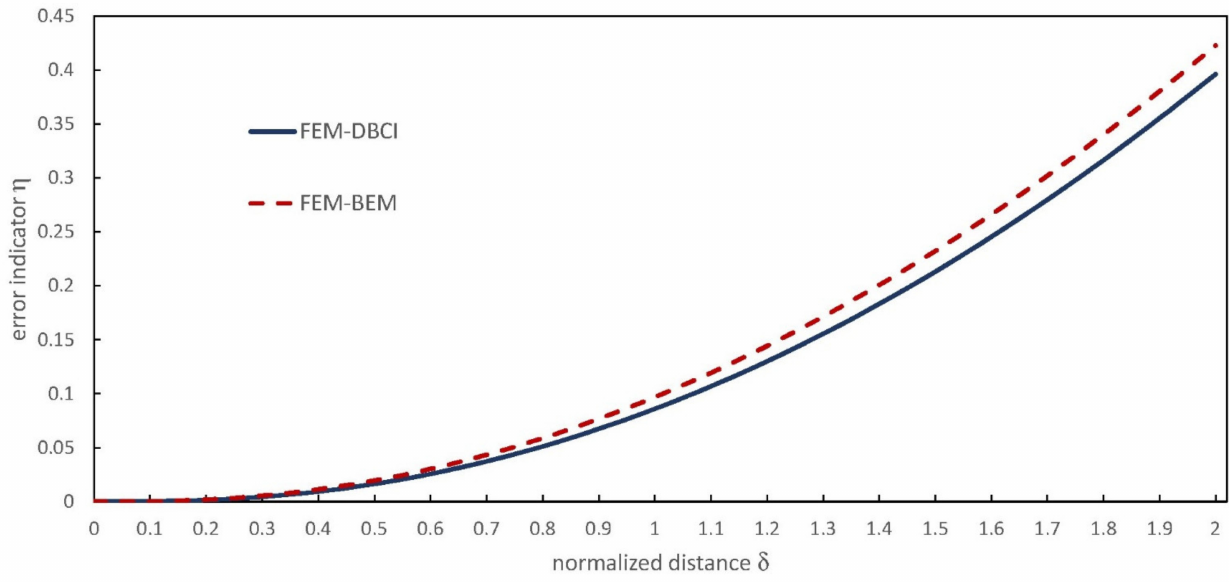
Figure 3. Behaviour of the error indicators of the FEM-DBCI and FEM-BEM methods for the analytical example of the charged conducting